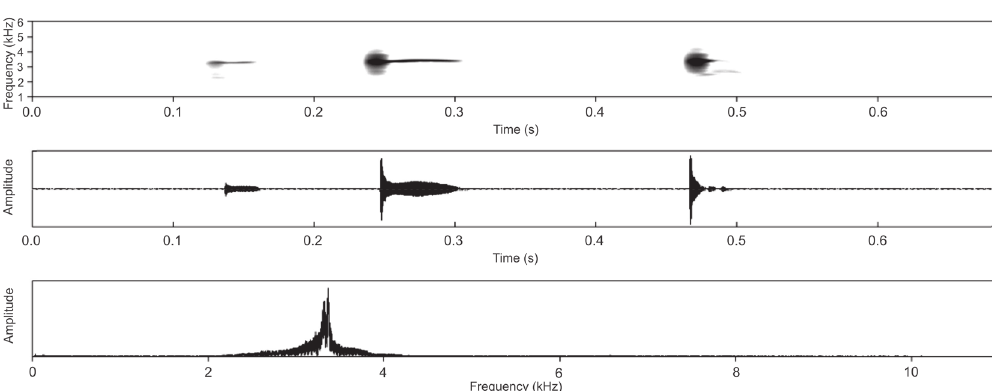
Figure 1. Spectrogram and oscillogram of the advertisement call of a male of Hypsiboas goianus recorded at Floresta Nacional de Silvânia, municipality of Silvânia, state of Goiás, Brazil. (Recording Marantz PMD660 and Sennheiser ME66 directional microphone; January 14, 2009; SVL = 28.91 mm; mass = 1.2 g; air temperature = 23.7°C). Call used in both experiments (see text).